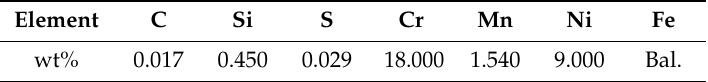
Table 1. Chemical composition of 304L stainless steel.